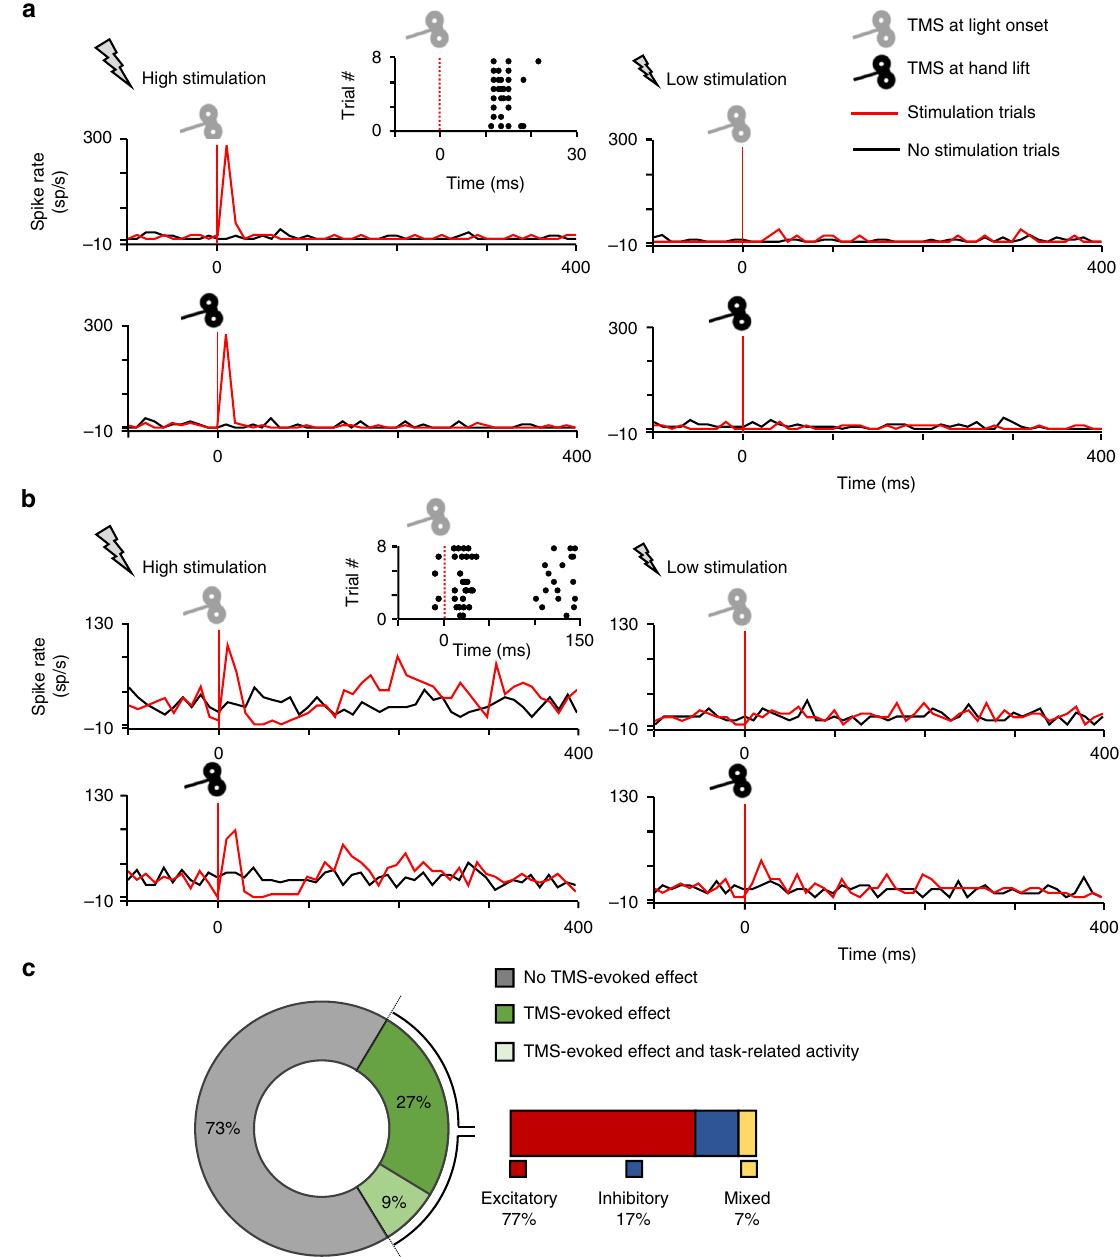
Fig. 2 Combined single-pulse TMS and extracellular recordings in parietal area PFG. a Example neuron exhibiting a short-lasting excitatory response to high TMS stimulation (120% rMT; left panel) compared to low stimulation (60% of rMT; right panel). Stimulation (red line plots) and no stimulation trials (black line plots) were randomly interleaved during the task. In a vast majority of PFG neurons, single-pulse TMS evoked a short-lasting burst of activity, which emerged around 20 ms after stimulation, and lasted for approximately 40 ms. The induced excitation did not depend on the time of the stimulation, reaching similar amplitudes when the pulse was applied at ‘ light ’ onset (gray coil: visual epoch of the VGG task) or at ‘ hand lift ’ (black coil: reaching epoch of the VGG task). A detailed, trial-by-trial, illustration of the excitatory effect is shown in the raster plot. b Second example neuron exhibiting a combined excitatory-inhibitory pattern of TMS-evoked activity in response to high (left panel) but not low stimulation (right panel). After an initial excitatory response, we observed a longer-lasting neuromodulation phase combining both inhibitory and excitatory periods for at least 300 ms. Similarly to A, the TMS-induced excitation did not depend on whether TMS was applied during the visual (gray coil) or reaching (black coil) epoch of the task. c : Proportion of PFG recorded neurons with no TMS-evoked effect (gray), TMS-evoked effects (green) and both TMS-evoked and task-related neural responses (light green). The inset on the right shows that amongst cells with TMS-evoked effects, we predominantly found excitatory (red), and few inhibitory (blue) or mixed (yellow) TMS-induced neural